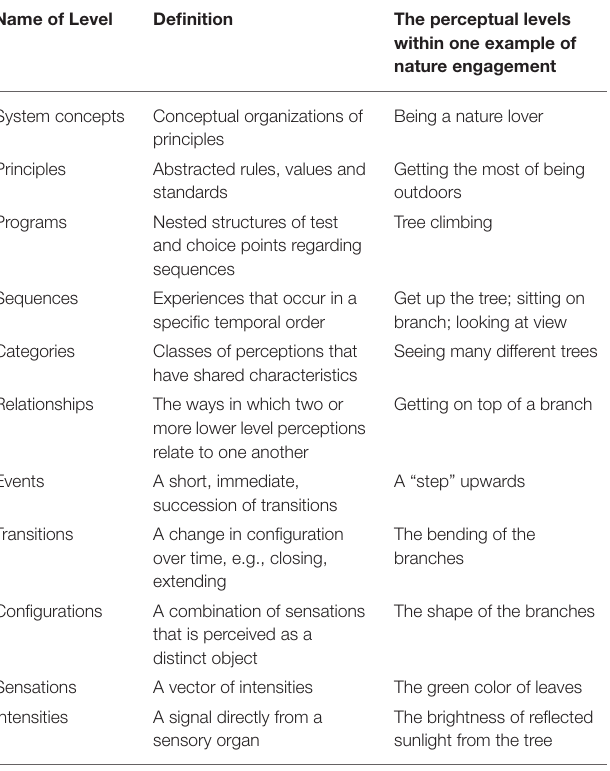
TABLE 1 | The perceptual levels within PCT (Powers, 1998) and examples of how they may be involved during nature engagement.